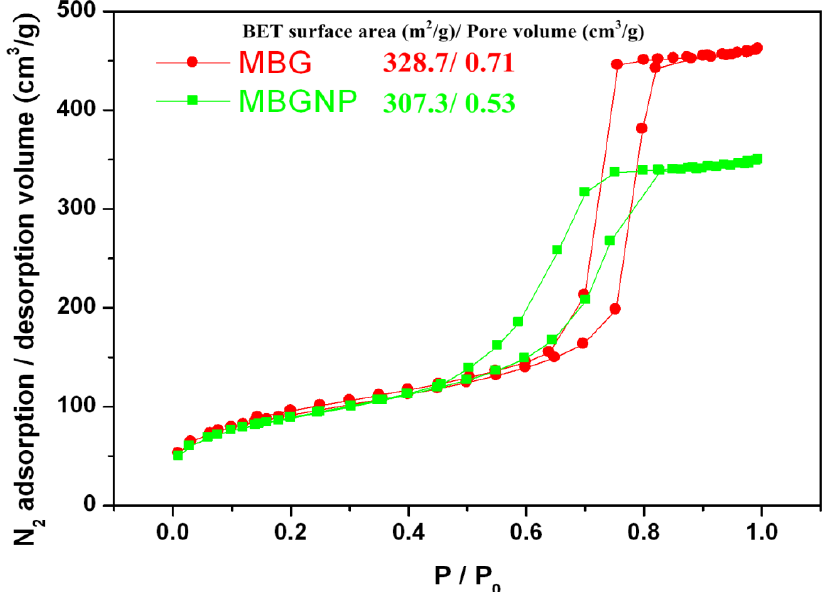
Figure 4. Nitrogen adsorption/desorption isotherm and the Brunauer–Emmett–Teller (BET) surface area with pore volume of MBG and